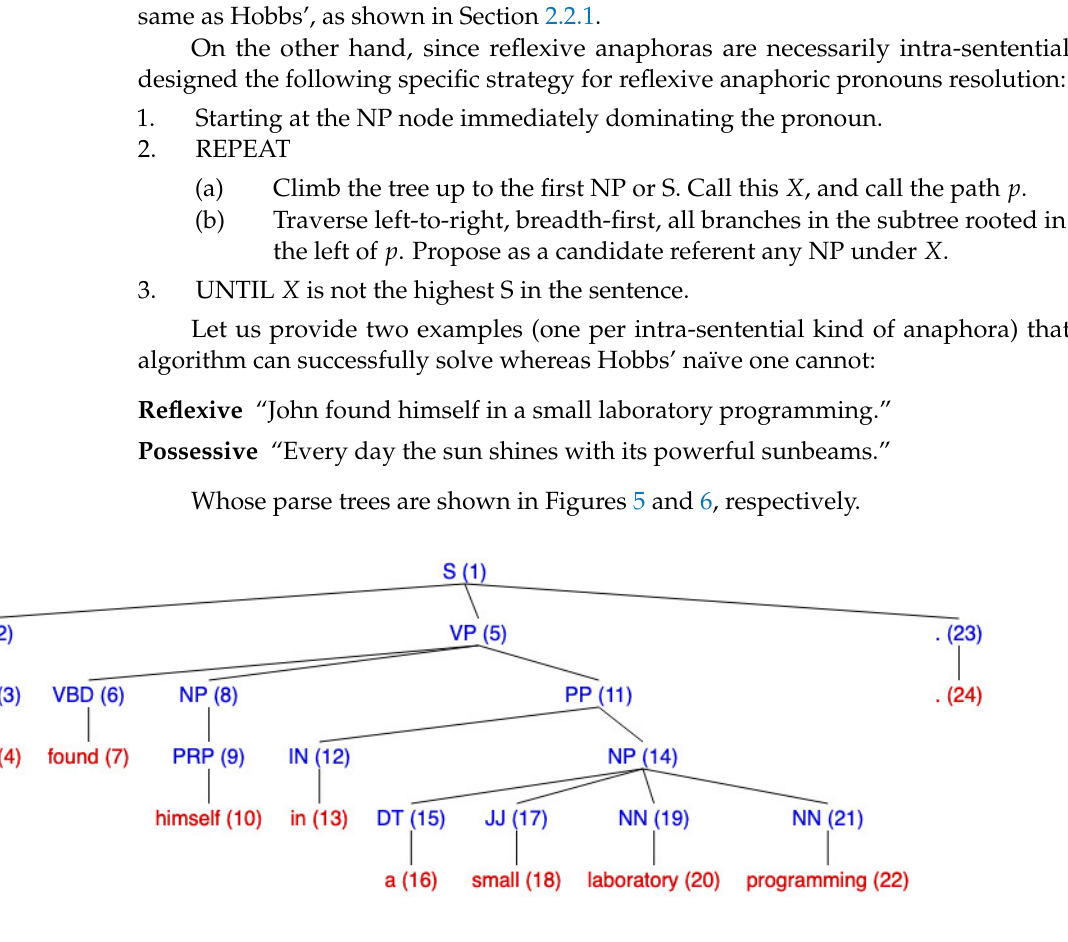
Figure 5. Sample text with reflexive